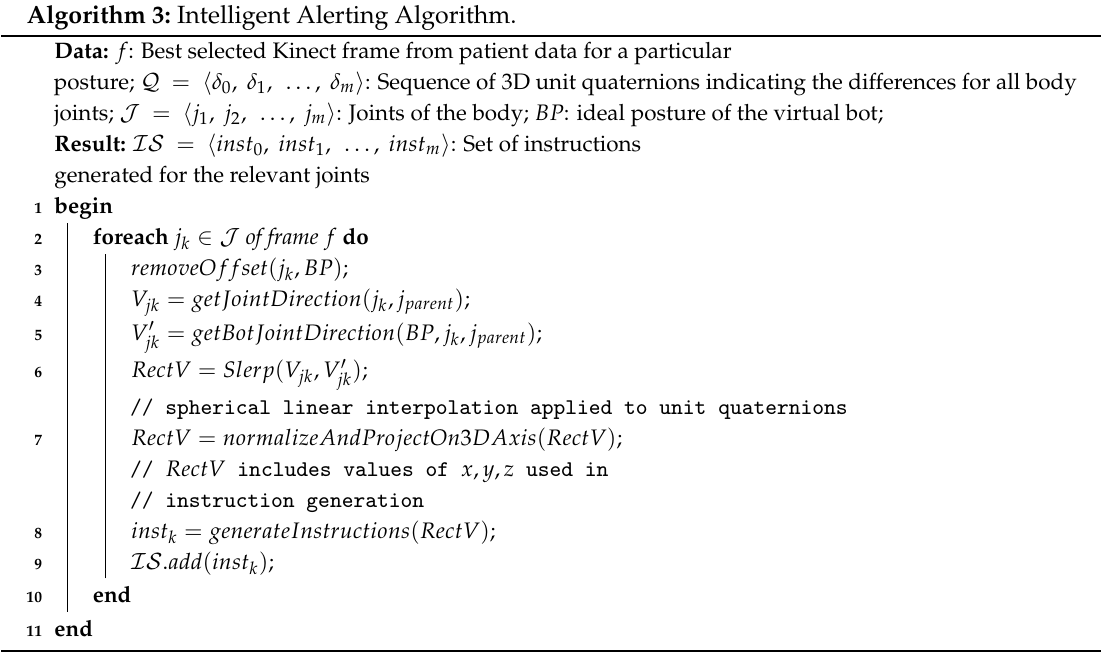
Algorithm 3: Intelligent Alerting Algorithm. Data: f : Best selected Kinect frame from patient data for a